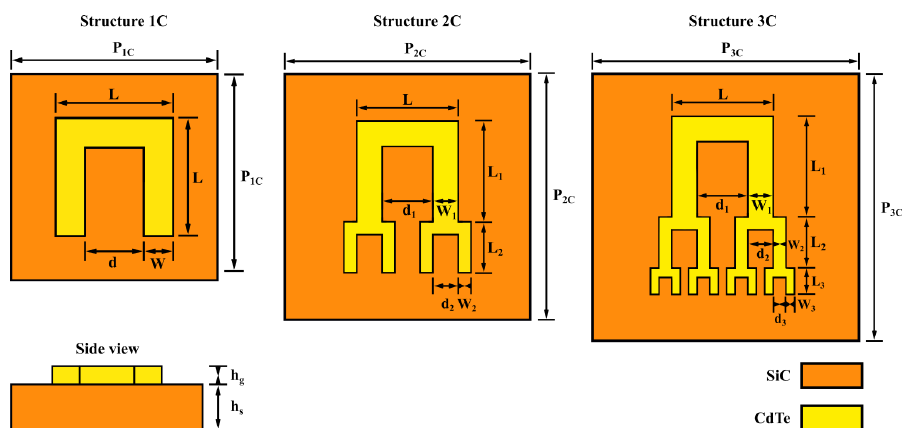
Figure 1. Layout of the fractal metasurface, together with the geometric parameters for the reference structure (1C), and the two C-shaped tree-like fractal structures (2C and 3C). Table 1. Geometric parameter values for the C-shapes in the configuration structures 1C, 2C and 3C.